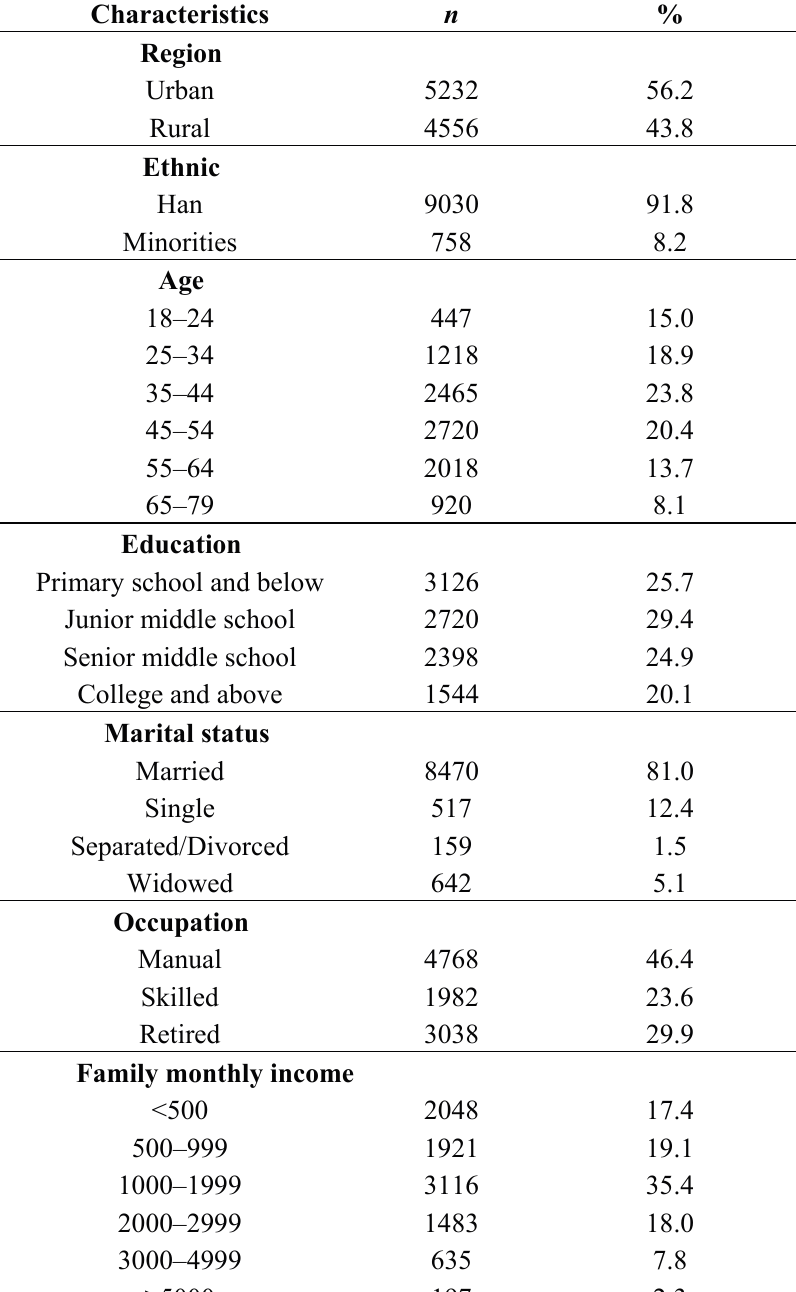
Table 1. Socio-demographic characteristics among non-smoking women aged 18 years or over in Jilin Province,